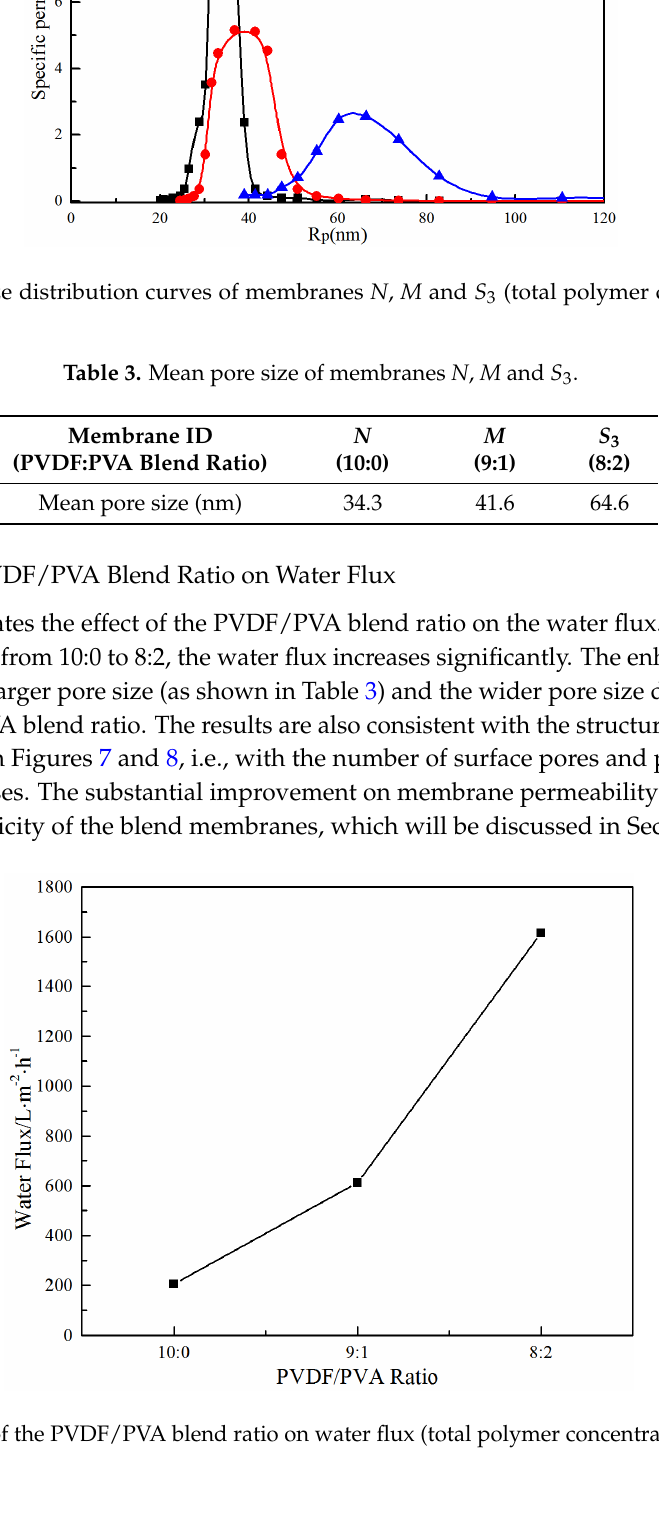
Figure 10. Effect of the PVDF/PVA blend ratio on water flux (total polymer concentration of 20 wt %).